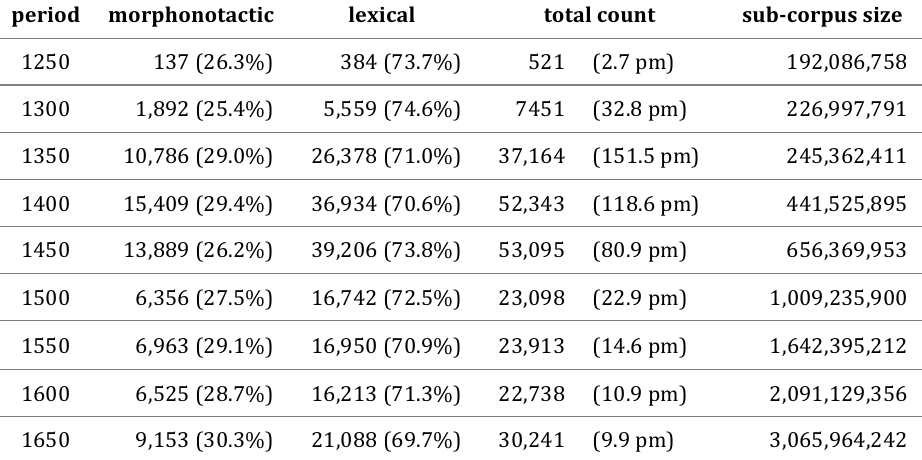
Table 1 . Frequencies of potential word-­‐final morphonotactic and lexical consonant clusters in the half-­‐centuries from 1250 to 1700 together with the sizes of the corresponding sub-­‐corpora. Figures in brackets denote fractions of morphonotactic and lexical sequences among all C(V)C(V) sequences (as %), and fractions of the latter sequences among the total number of words in the respective sub-­‐corpora (per million